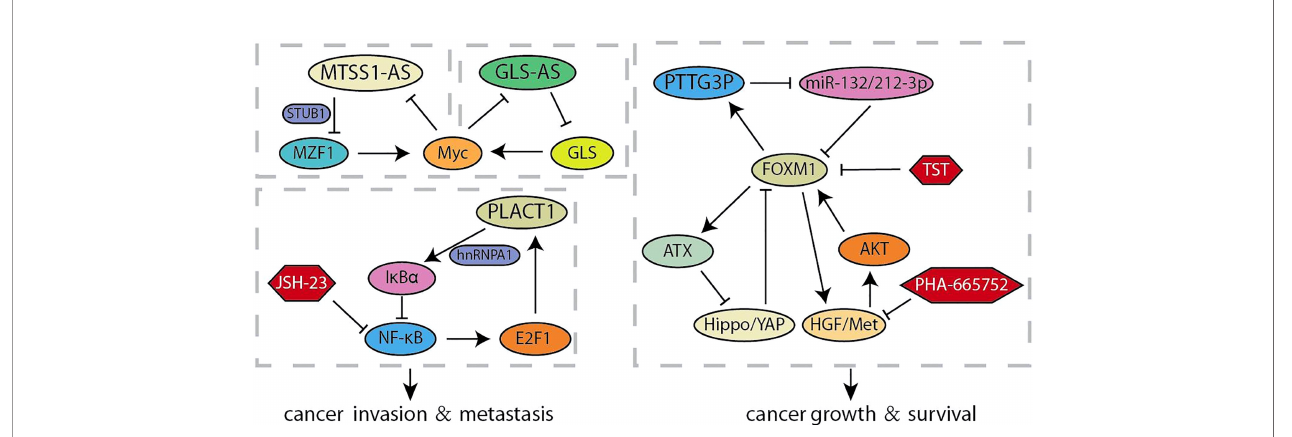
FIGURE 3 | Summary of LncRNA related feedback loops in pancreatic